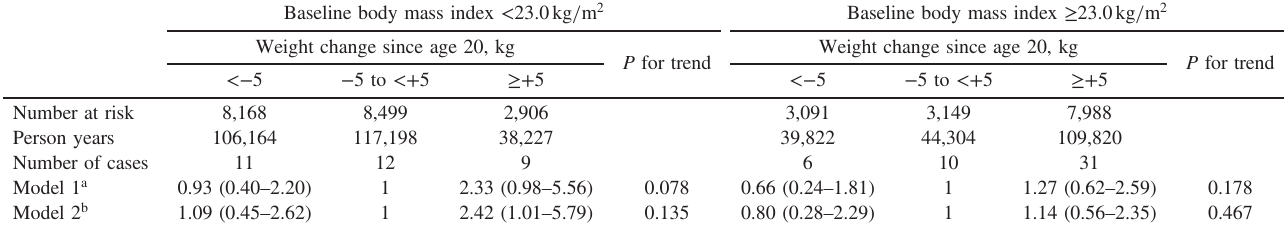
Table 4. Hazard ratios (95% con fi dence intervals) of incident endometrial cancer according to weight change, strati fi ed by baseline body mass index